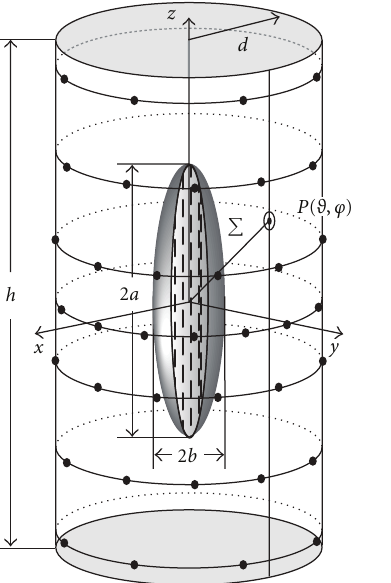
Figure 6: Cylindrical scanning: the prolate ellipsoidal modelling.